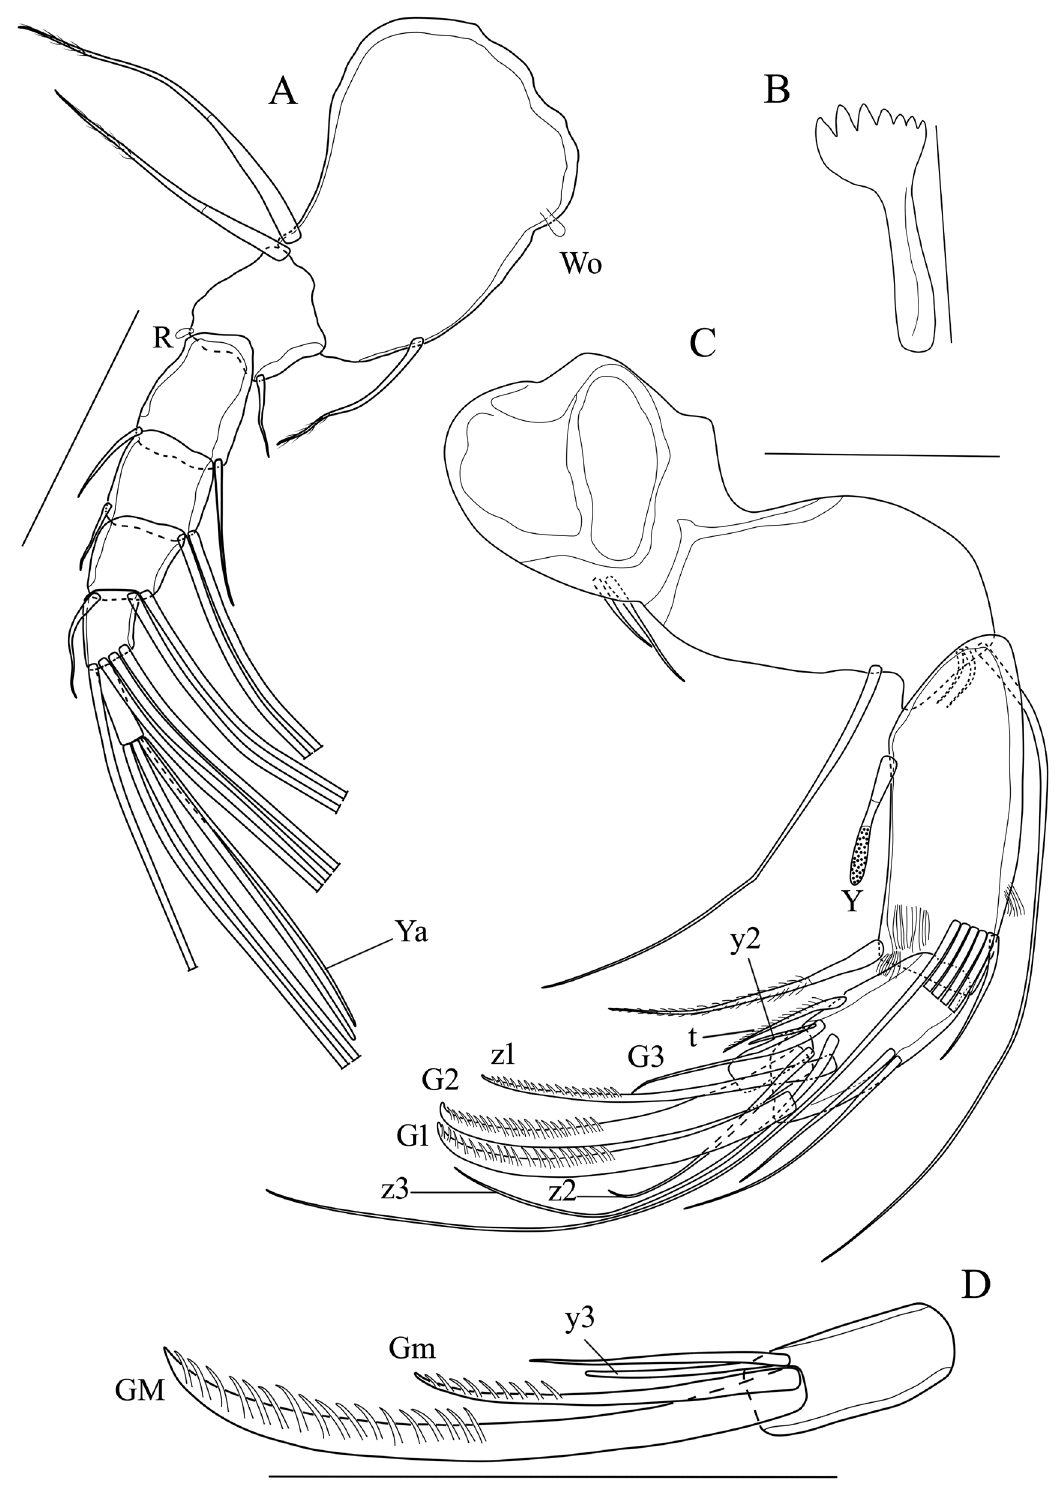
Fig. 4. Brasilodopsis baiabonita gen. et sp. nov. from Bonito, State of Mato Grosso do Sul, ♂. A . A1 (MZUSP 41825). B . Rake-like organ (MZUSP 41825). C . A2, without the terminal segment (MZUSP 41827). D . A2, terminal segment (MZUSP 41827). Abbreviations: see text and Material and methods. Scale bars: A, C–D = 50 µm; B = 20